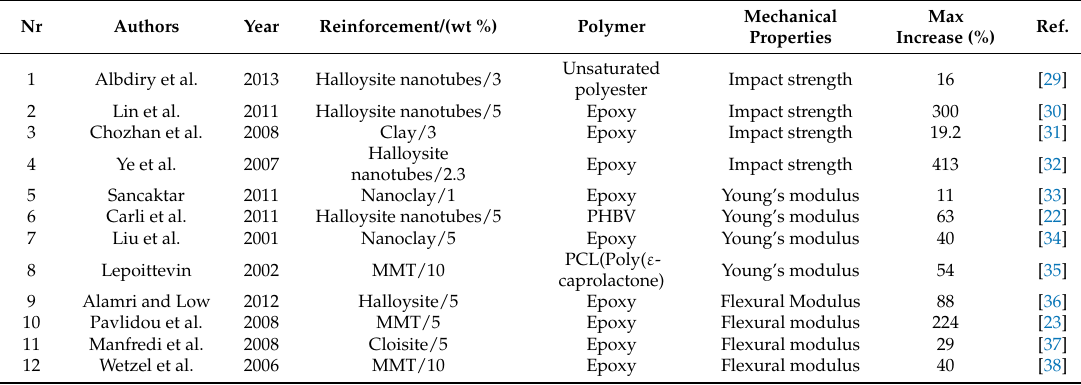
Figure 1. Location of the collected seawater, South Shields Beach, United Kingdom. Table 1. Mechanical properties of clay based composites from literatures.